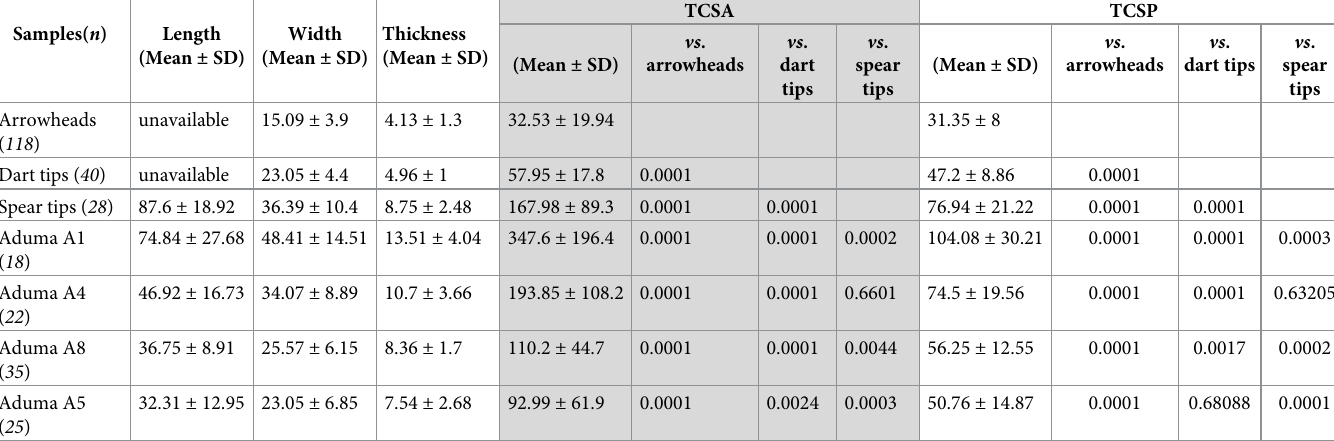
Table 1. Comparison of Aduma points with ethnographic arrowheads, dart tips, and spear tips using independent sample t -test. (Units in mm/mm 2 ; SD = Standard Deviation). Samples( n ) Length (Mean ±